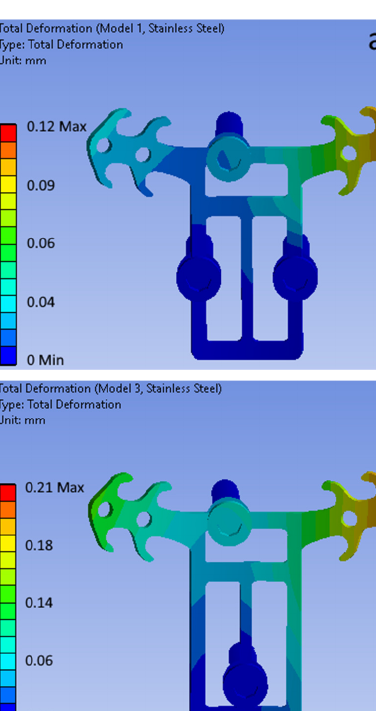
Figure 7. Equivalent stress fields for ( a )–( d ) mini-implant configurations (POD material—titanium alloy). ( a ) Model 1. ( b ) Model 2. ( c ) Model 3. ( d ) Model 4.